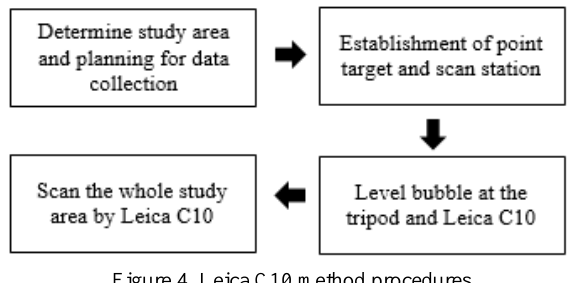
Figure 4. Leica C10 method procedures